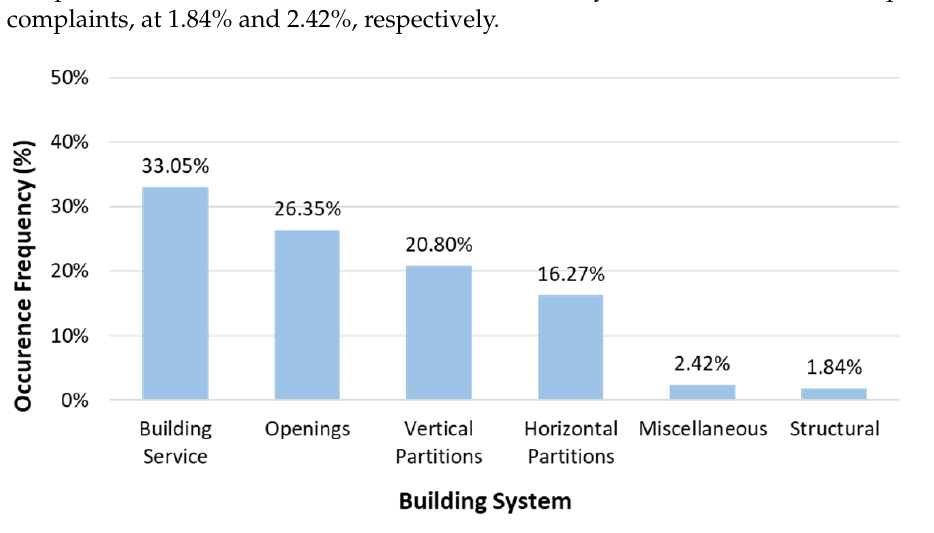
Figure 8. Complaint frequency of the building systems.